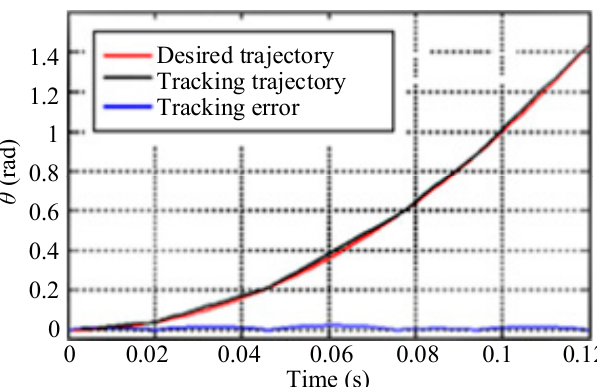
Figure 15. Plots of the shaft angular displacement tracking based on the position–velocity–time (PVT) mode.